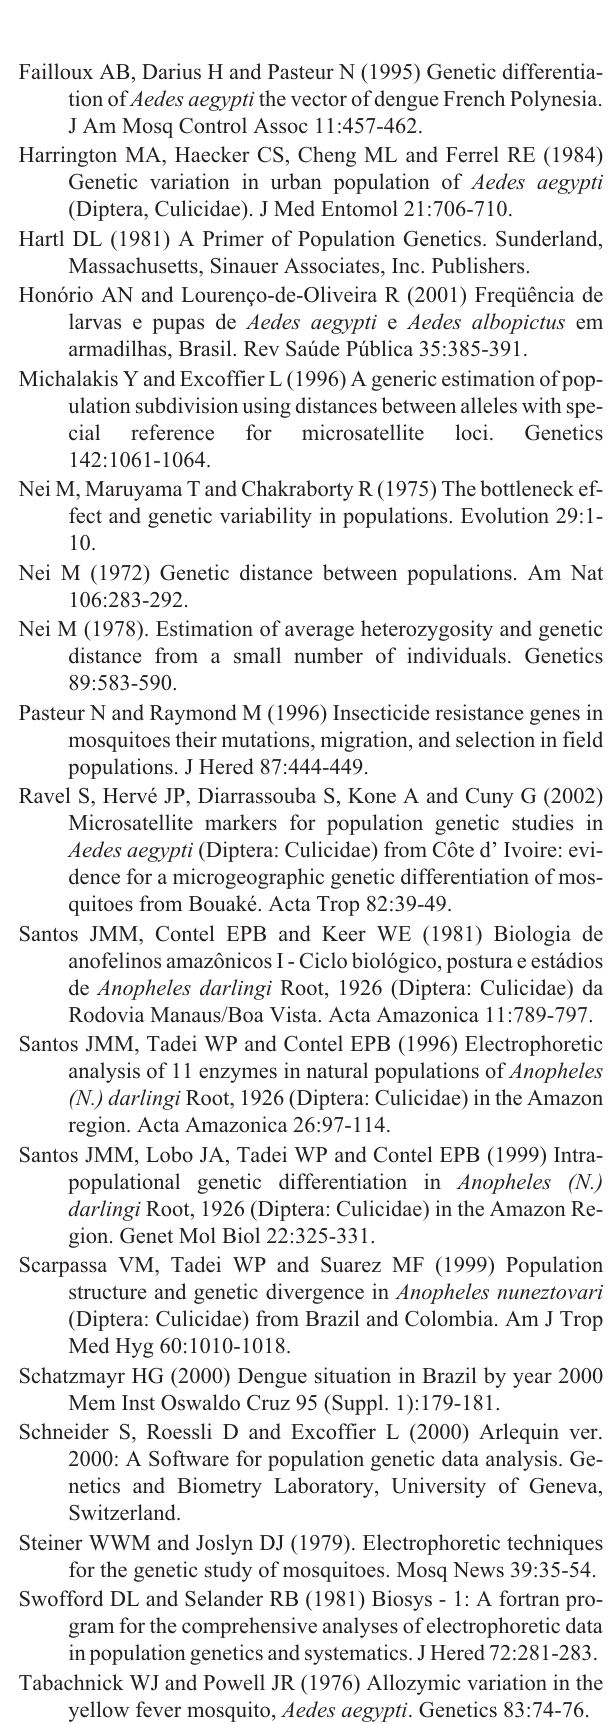
Tabachnick WJ and Powell JR (1976) Allozymic variation in the yellow fever mosquito, Aedes aegypti . Genetics